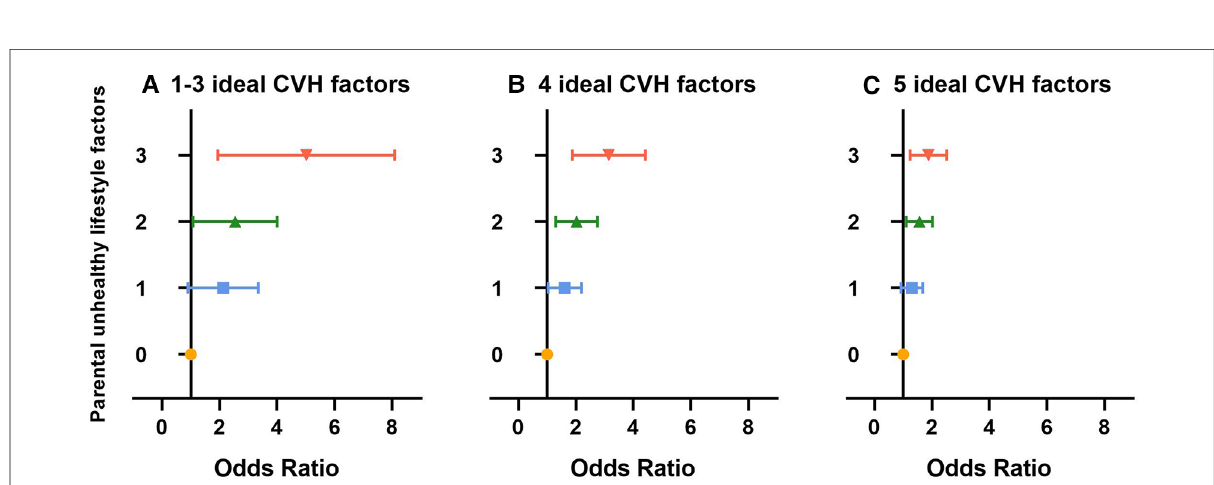
FIGURE 4 Association between combined unhealthy behaviors of parents and offspring's different groups of nonideal CVH status: ( A ) 1-3 ideal CVH factors, ( B ) 4 ideal CVH factors, ( C ) 5 ideal CVH factors. Error bar was 95% CI. The combined behaviors of parents were examined as riable (vs. ideal CVH status). Data adjusted for provinces, resident area, family history of chronic diseases, family monthly incng's sex, age, birth weight, single-child status, breast feeding status, and parental highest education attainment. CVH, cardiovascular